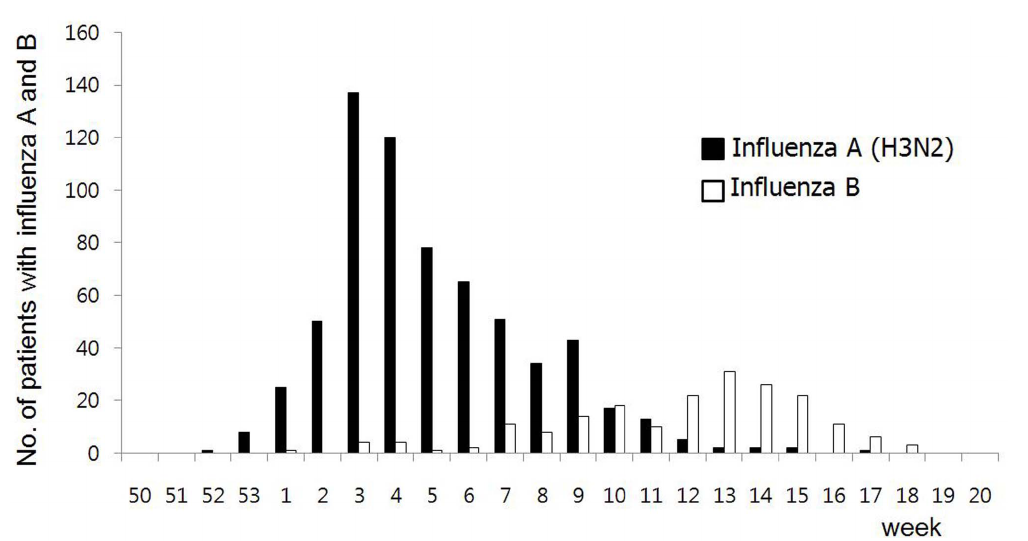
Figure 2. Weekly number of adult patients with laboratory-confirmed influenza A and B, 2011–2012. doi:10.1371/journal.pone.0062685.g002 PLOS ONE |